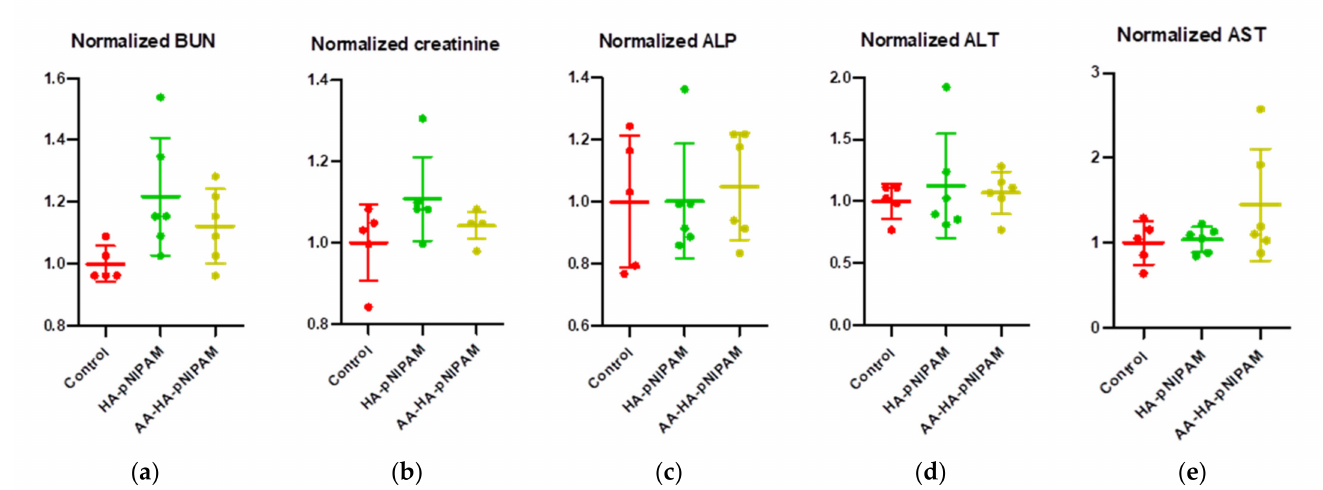
Figure 8. Biochemical analyses from the blood samples of rats after treatment with control, HA-pNIPAM and AA-HA- pNIPAM. The biochemical parameters analyzed were ( a ) blood urea nitrogen (BUN), ( b ) creatinine, ( c ) alkaline phosphatase (ALP), ( d ) alanine aminotransferase (ALT) and ( e ) aspartate aminotransferase (AST).